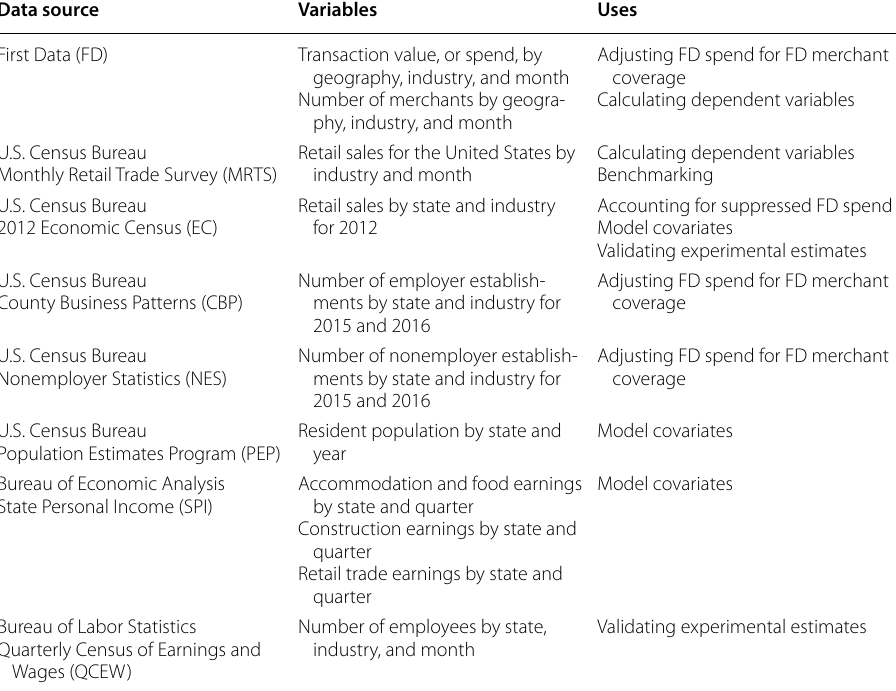
Table 2 Data sources, variables, and their uses in estimation Data